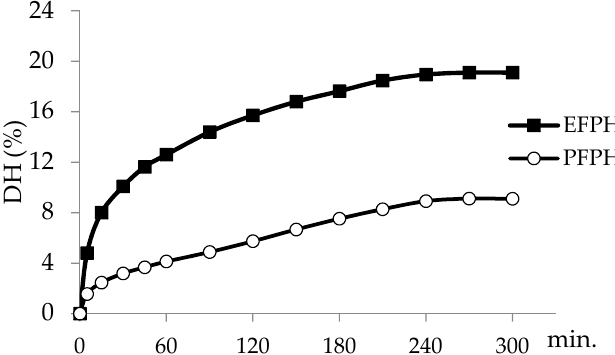
Figure 1. Kinetic of fenugreek proteins hydrolysis. E / S ratio = 5 U / mg proteins. EFPH: Esperase-fenugreek proteins hydrolysate. PFPH: Purafect-fenugreek proteins hydrolysate.